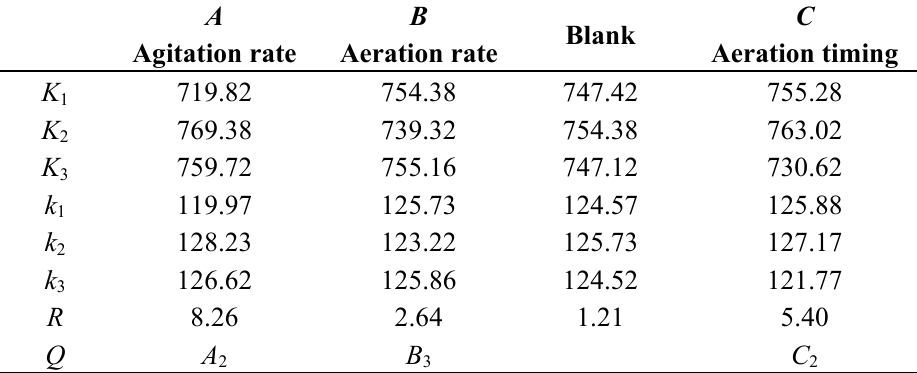
(3 4 ) orthogonal experiments for ethanol concentration. 9